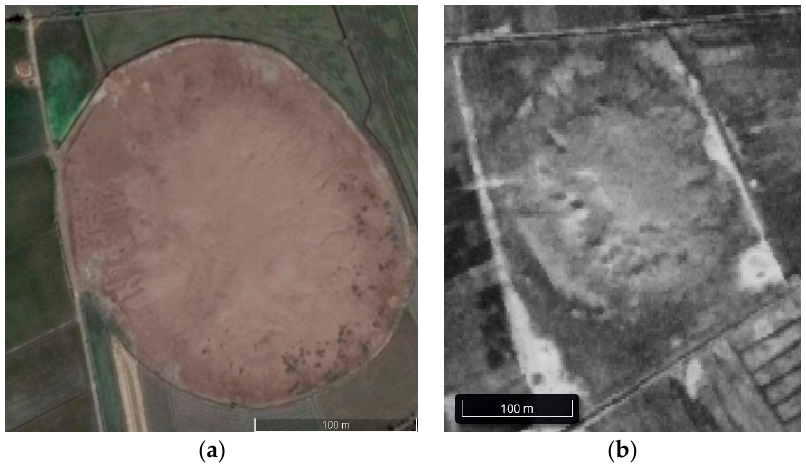
Figure 10. ( a ) The site of Kom Bunduq. Image courtesy Google Earth; ( b ) 1968 CORONA image. Image courtesy of the Center for Advanced Spatial Technologies, University of Arkansas/U.S. Geological Survey.